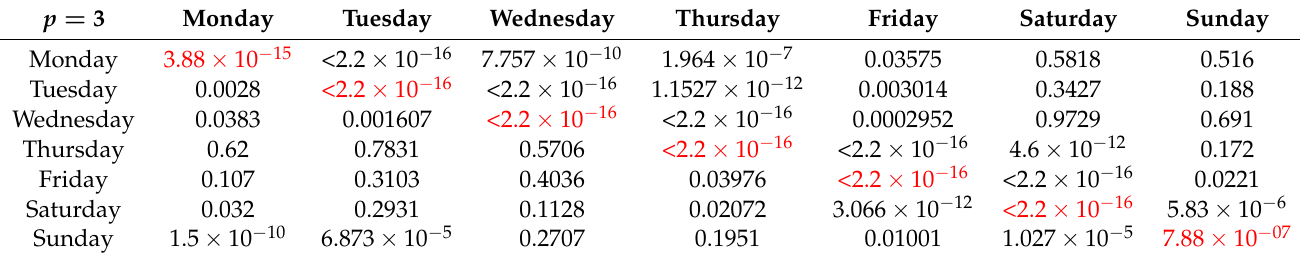
Table 6. Classical tests between temperature and electricity demands. We highligth the diagonal in